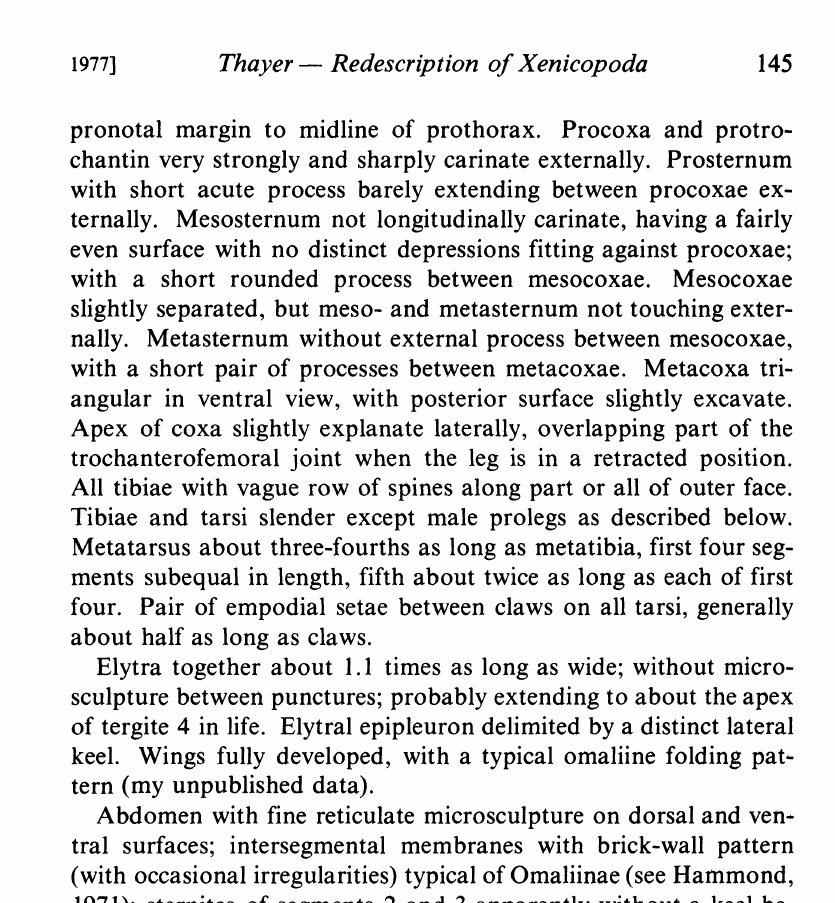
Figs. 1-8. Xenicopoda helenae Moore and Legner. 1-2. Mandibles; 1., ventral; 2., dorsal view. 3. Head, dorsal view (large circles ocelli, small circles dorsal tentorial pits). 4. Abdomen, segments 2-8 and (male) genital segment, dorsal view. 5. Eighth abdominal sternite and external female genitalia, ventral view. 6-8. Male genitalia; 6., Genital segment, ventral view; 7., Aedeagus (as positioned within ab- domen), dorsal view; 8., Genital segment, dorsal view. Membranous areas of geni- talia stippled. Scale line 0.5